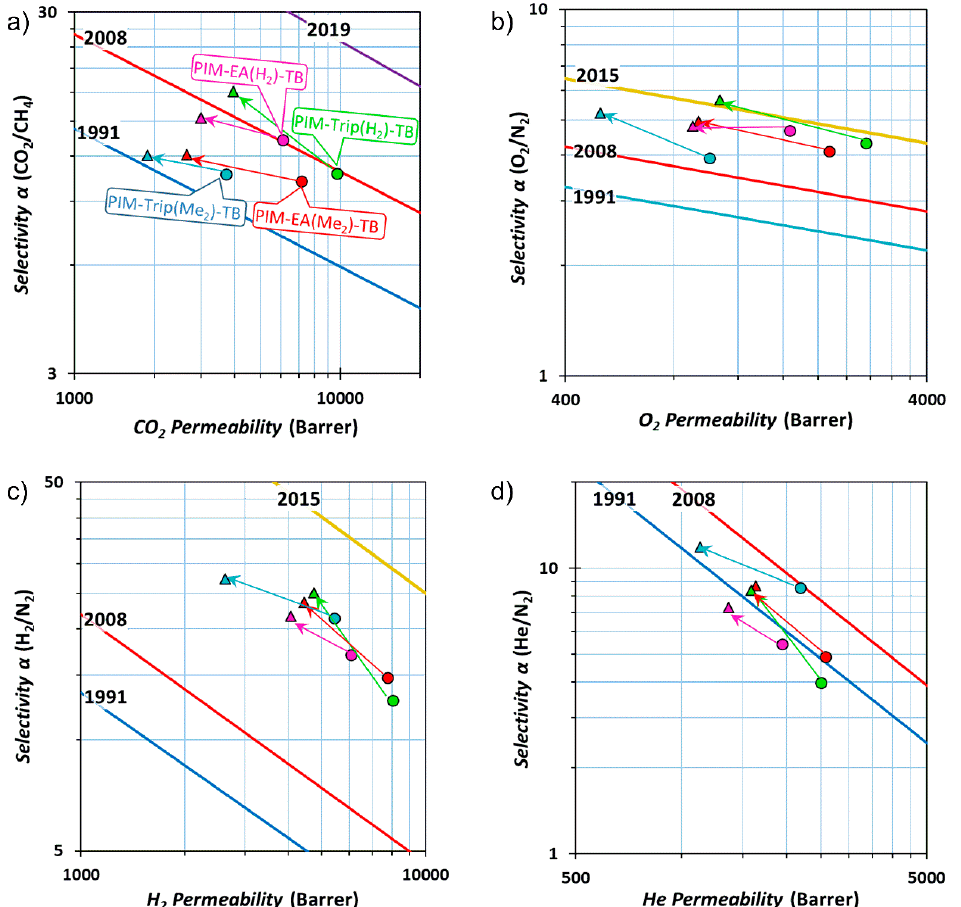
Figure 4. Robeson’s plots of the four TB-PIMs. Measurements at 25 °C and 1 bar feed pressure. Data are reported for methanol treated (circles) and aged (triangles) samples. Arrows indicates the change in permselectivities for aged samples of PIM-Trip(H 2 )-TB (green, 102 days), PIM-Trip(Me 2 )-TB (blue, 407 days), PIM-EA(H 2 )-TB (violet, 119 days) and PIM-EA(Me 2 )-TB (red, 106 days). Continuous lines represent the different upper bounds: 1991 [21], 2008 [23], 2015 [24], and 2019 [25].